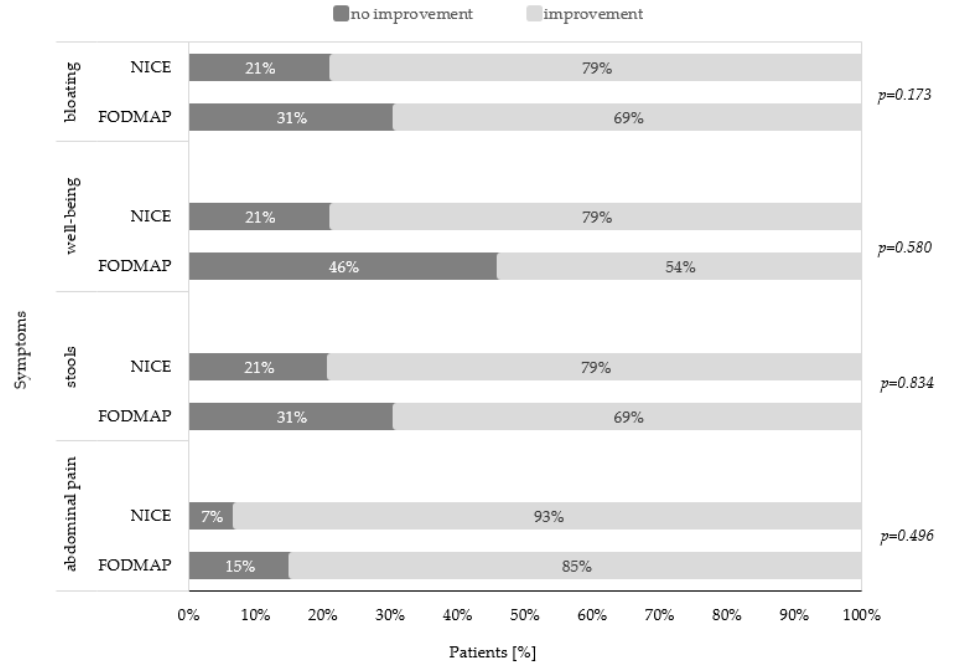
Figure 2. Parental assessment of children’s symptoms in the low fermentable oligosaccharides, disaccharides, monosaccharides, and polyols (FODMAP) group and National Institute for Health and Care Excellence (NICE) group after dietary intervention.